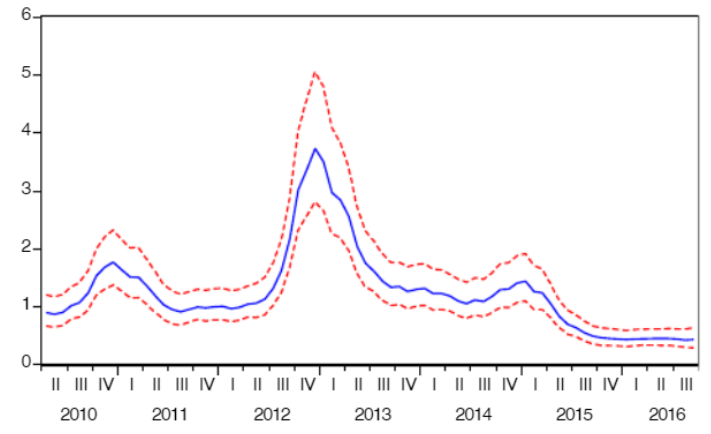
Fig. 2 The impulse response process of the combined negative shock of banks and